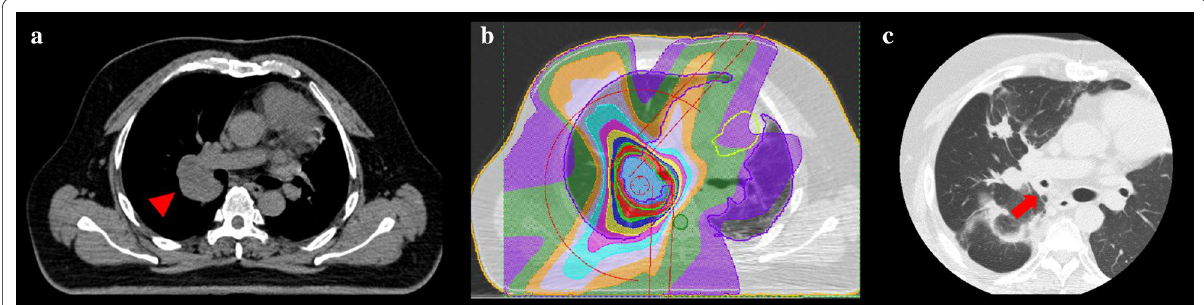
Fig. 1 Computed tomography images before and after radiation therapy. a A metastatic tumor in the right hilum (red arrowhead). b Treatment plans for stereotactic body-radiation therapy. c Axial view after radiation therapy showing stenosis of the right main bronchus (red arrow)